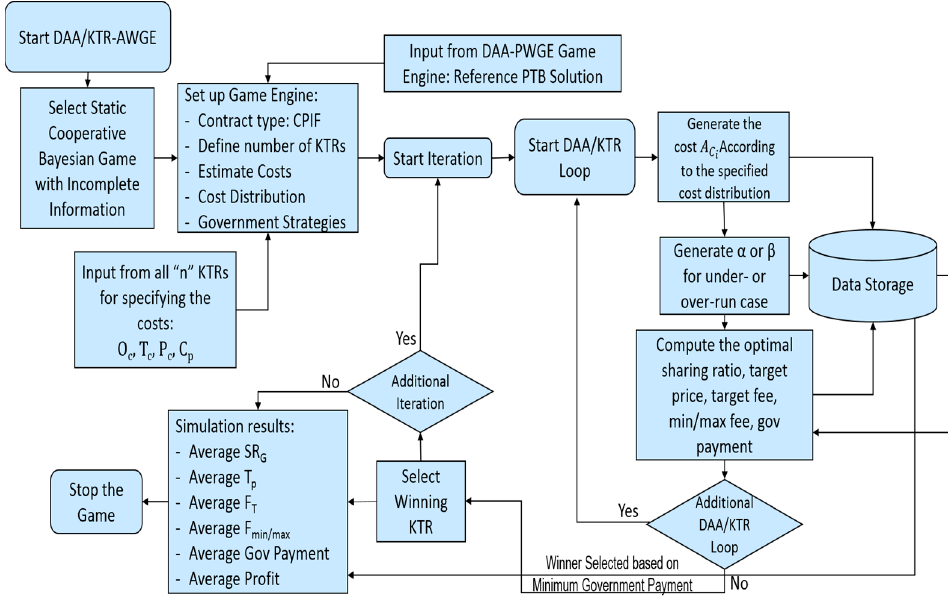
Figure 9. DAA-AWGE Modelling and Simulation Flow Diagram for CPIF Contract Type.